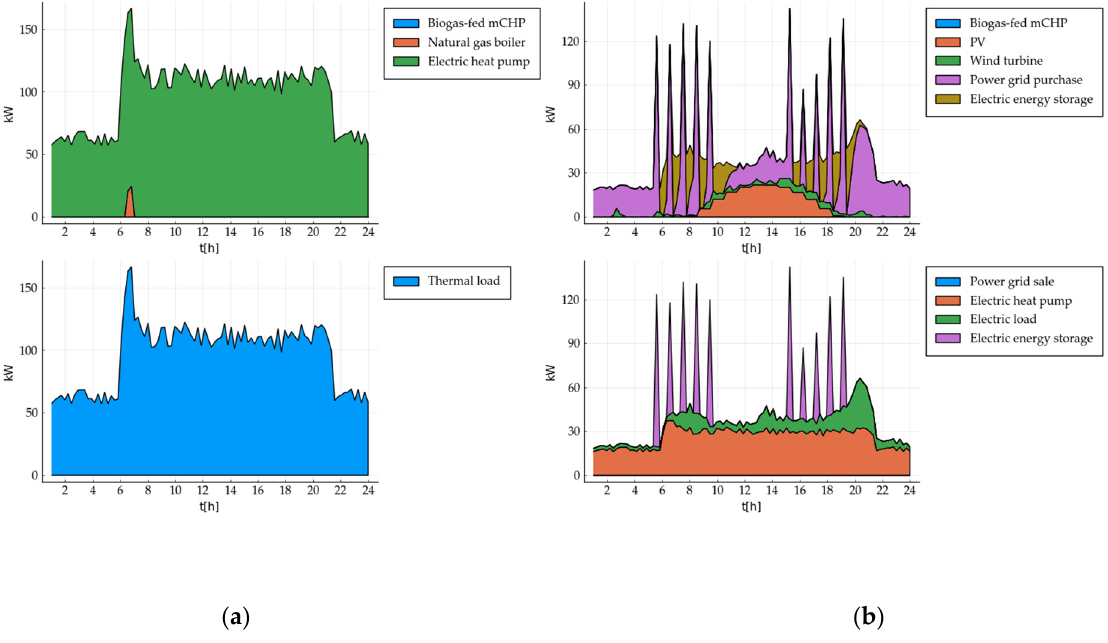
Figure 15. Daily consumption and production pattern for Case 2 (Combined Design and Operations Optimization) with a biogas price of 0.39 €/m 3 : thermal production ( a -up) consumption ( a -down); electricity production ( b -up) consumption ( b -down).